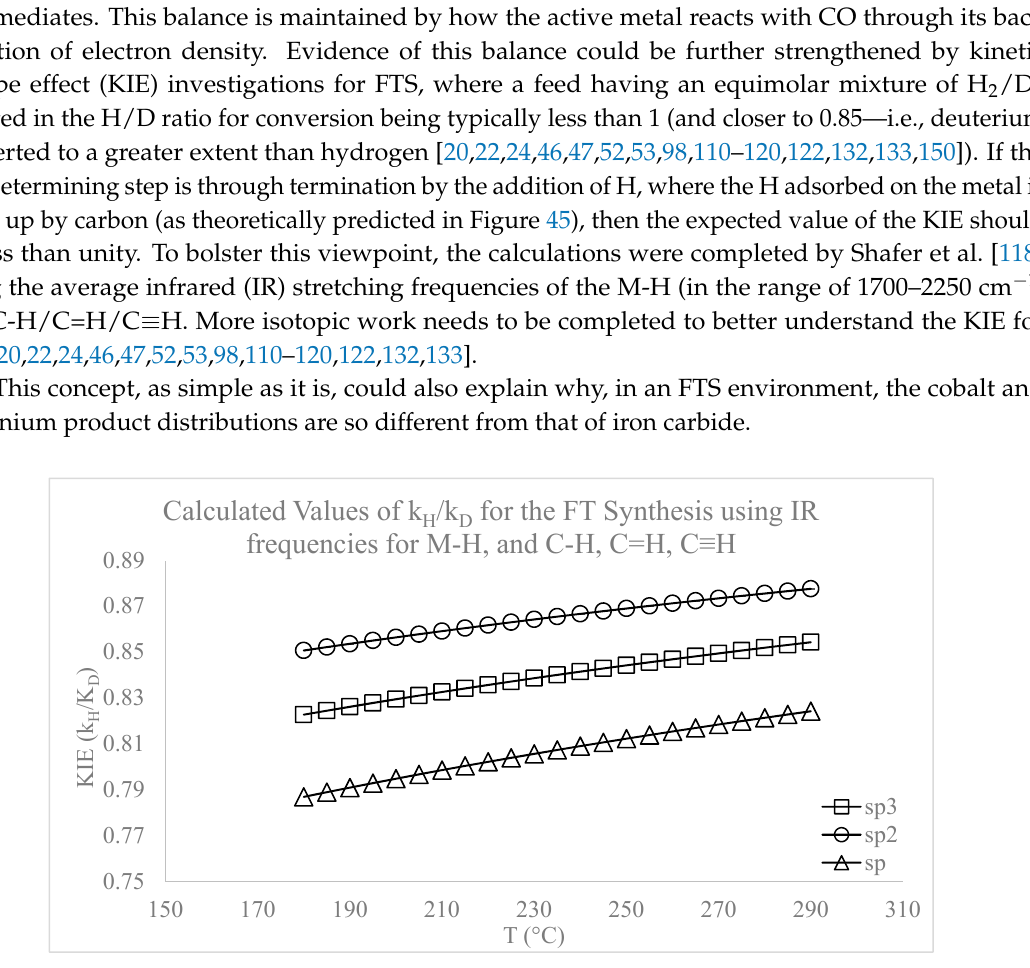
Figure 45. The calculated KIE value for FTS where H addition is the rate determining step, provided that the KIE for FTS was not significantly affected by hydrogen coverage. These calculations follow the ones that were performed by Shafer et al. [114–118]. Ratios are derived from the activation energy using IR stretching frequencies as the energy differences. The k H /k D values are taken from the average cm − 1 for the M-H range (1700–2250 cm − 1 ). The standard deviations are ±0.06.